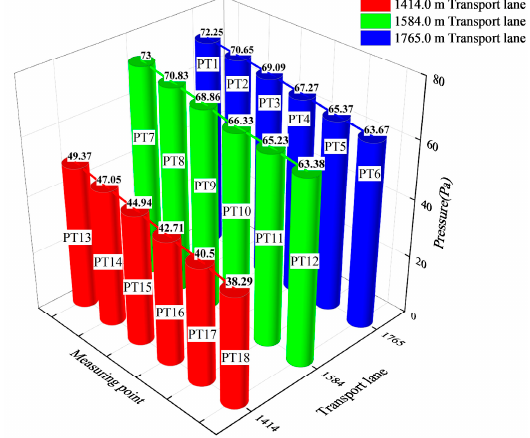
Figure 13. The pressure difference of measuring points in each transport lane. The airflow in the transport lane belongs to turbulent flow. Under the influence of piston wind, the airflow particles collide, mix and exchange with each other. Turbulence is a random motion process that changes irregularly in time, but it has a regular probabil- ity distribution. Therefore, this paper uses probability density distribution to analyze the statistical characteristics of the piston air flow in each transport lane [29]. Three feature points with different distances from the entrance of the lane were selected along the cen- tral axis of the three transport lanes of 1765.0 m, 1584.0 m and 1414.0 m, respectively, for wind speed probability density statistics, and they were compared with the probability density distribution of normal distribution function by Formula (3). The results are shown in Figures 14–16. ( c ) Figure 14. Probability density of characteristic points of 1765.0 m transport lane: ( a ) Point one, ( b ) Point two, ( c ) Point three.